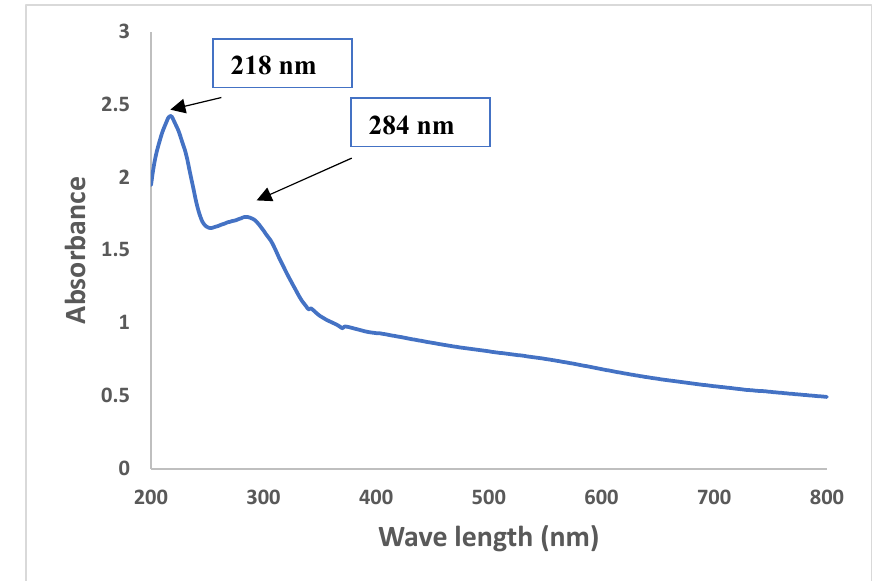
Figure 2. The UV-visible spectrum of biosynthesized SeNPs.